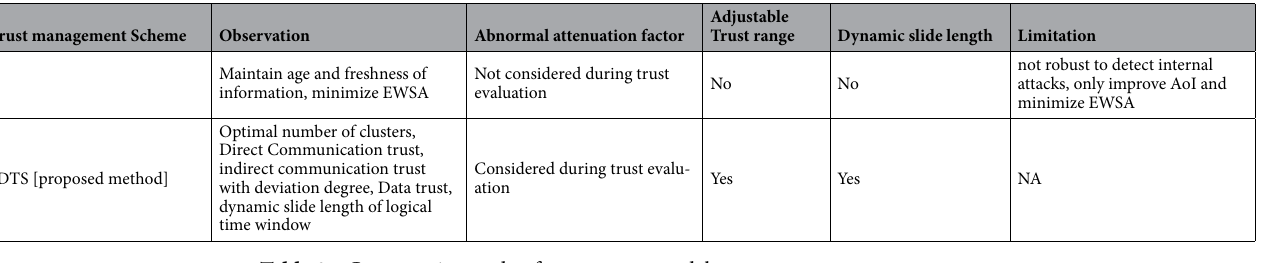
Table 2. Comparative study of recent trust